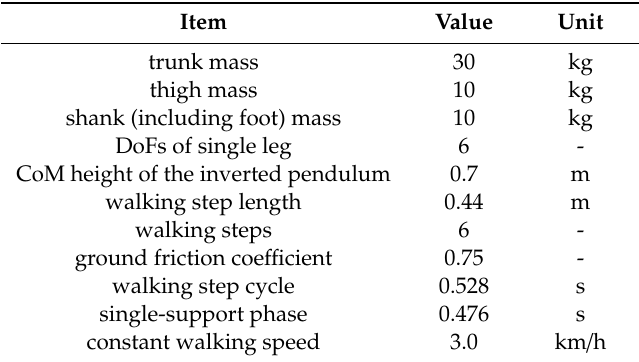
Table 1. Dynamics parameters in the simulation.